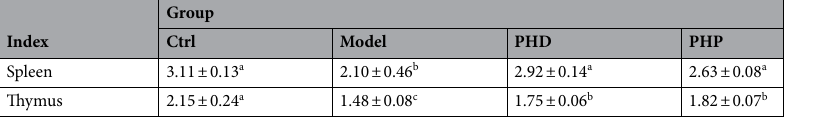
Table 3. Effect of PHD and PHP on the immune organ index of rats (mg/g). Data are expressed as mean ± SD (n = 5). Different lowercase letters (a, b and c) were significantly different at the level of p < 0.05.